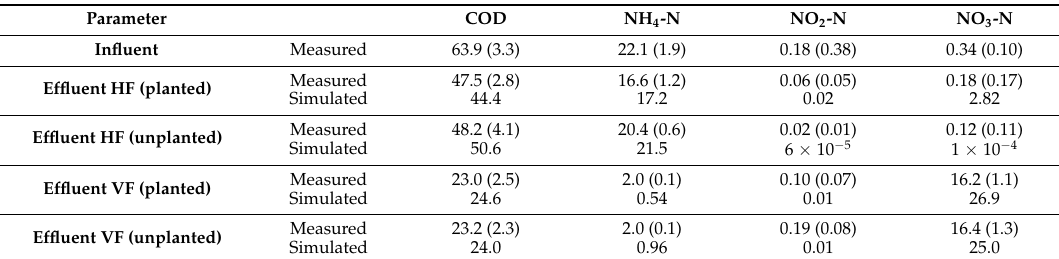
Table 8. Measured and simulated influent and effluent concentrations of planted and unplanted VF and HF wetlands for secondary treatment of municipal wastewater (in mg/L, standard deviations in brackets, adapted from